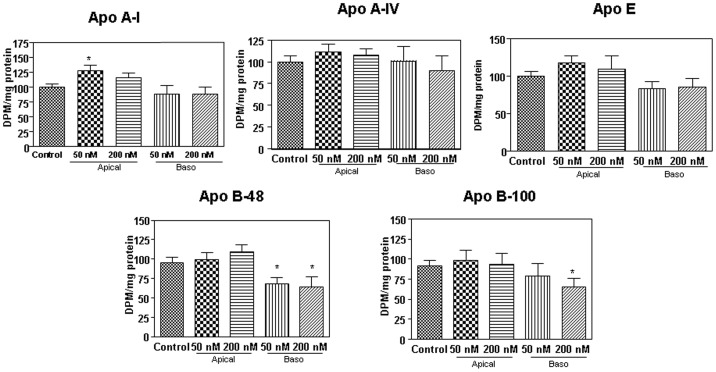
Effects of the administration of PYY (1–36) to the apical or basolateral medium on the synthesis of apolipoproteins (apo).Epithelial cells at 14 days post-confluence were incubated with [35S]-methionine in the presence of PYY (1–36) (50 or 200 nM) and unlabeled oleic acid for 24 h to stimulate apo biogenesis. At the end of the labelling period, cells were washed, homogenized, and centrifuged. Supernatants from the cell homogenates were then reacted with excess antibodies for 18 h at 4°C to precipitate specific apos. Immune complexes were washed and analyzed by linear 4–15% SDS-PAGE. After electrophoresis, gels were sliced and counted for radioactivity. Data represent means ± SD for n = 3 separate experiments in each group. Values are reported as % of control values representing 100%. *P<0.05 vs. controls.